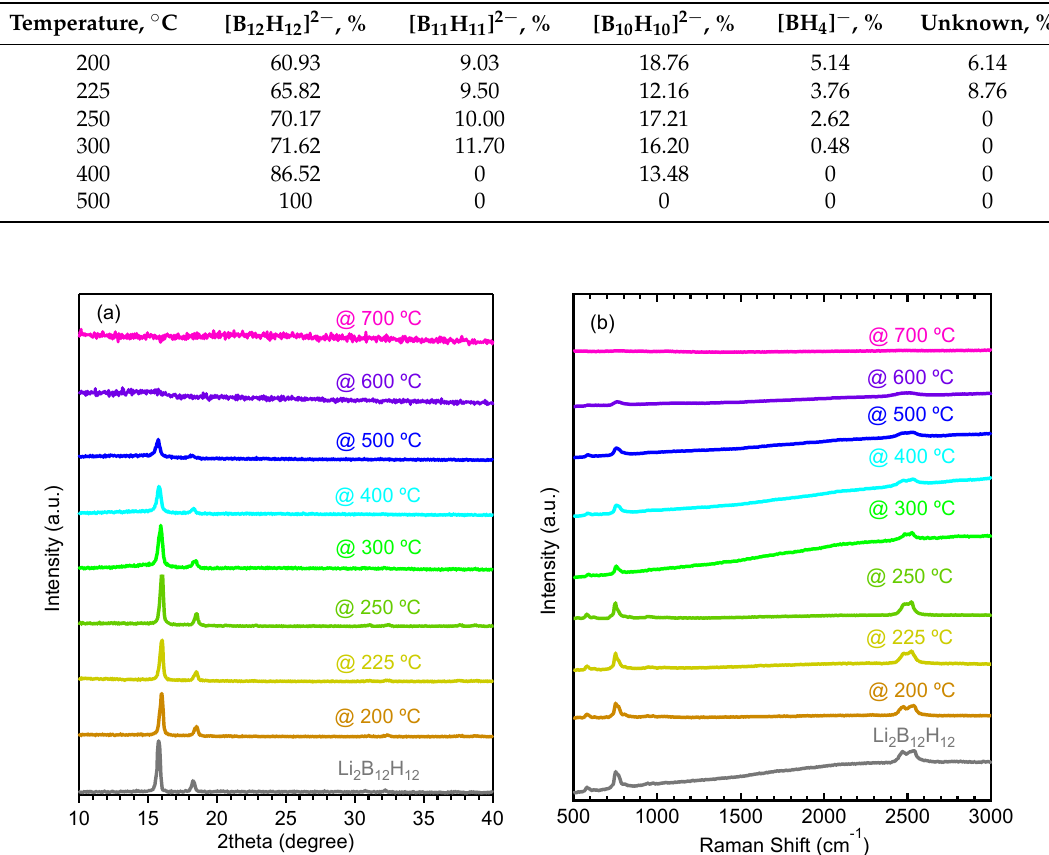
Figure 2. Ex-situ ( a ) X-ray diffraction (XRD) patterns and ( b ) Raman spectra of anhydrous Li 2 B 12 H 12 and heated up to respective temperatures.